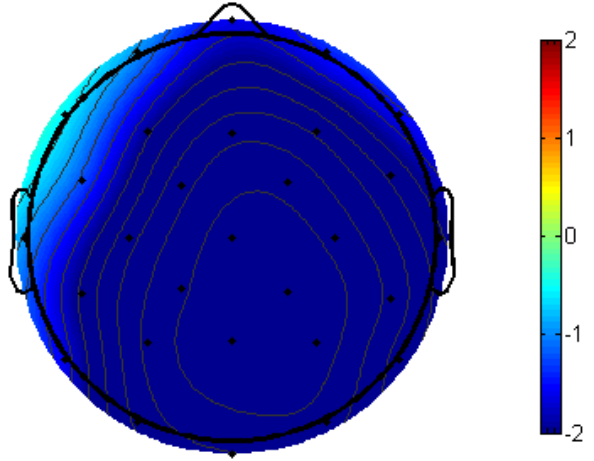
Figure 7. The 300–500-ms voltage map of semantic priming e ff ect (semantically unrelated–semantically Figure 7. The 300 – 500-ms voltage map of semantic priming effect (semantically unrelated – related) across all participants, with blue indicating a net negative e ff semantically related) across all participants, with blue indicating a net negative effect.